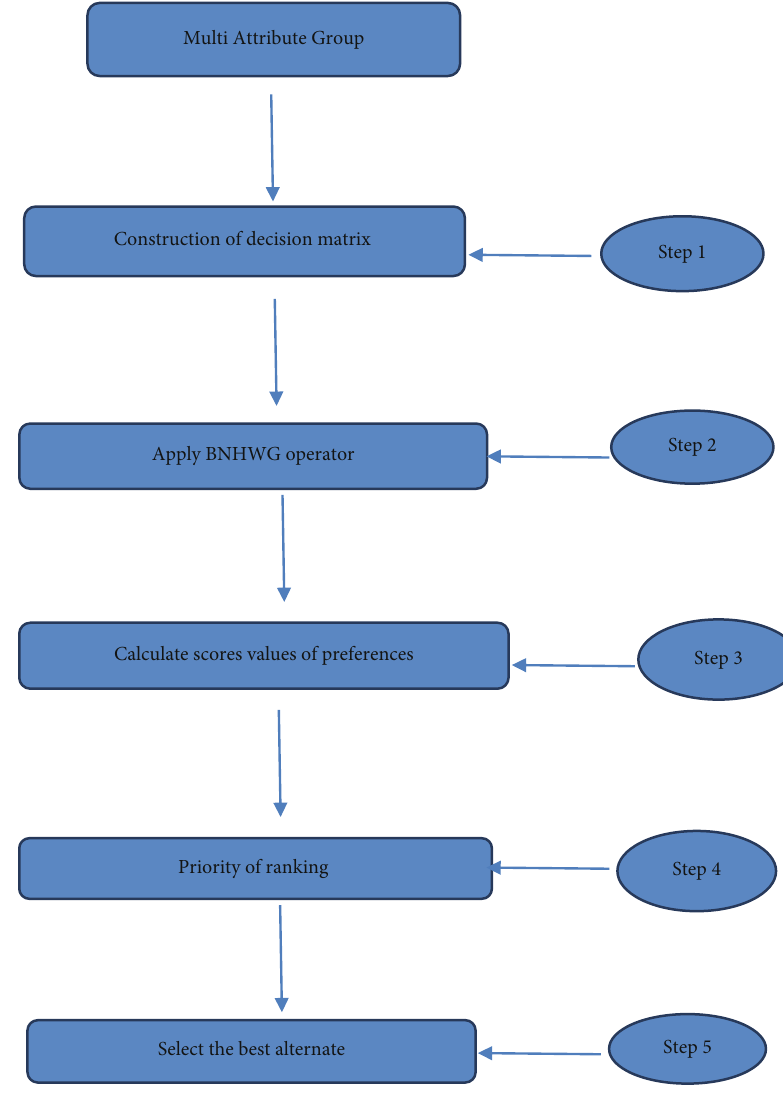
Figure 1: Flow chart for